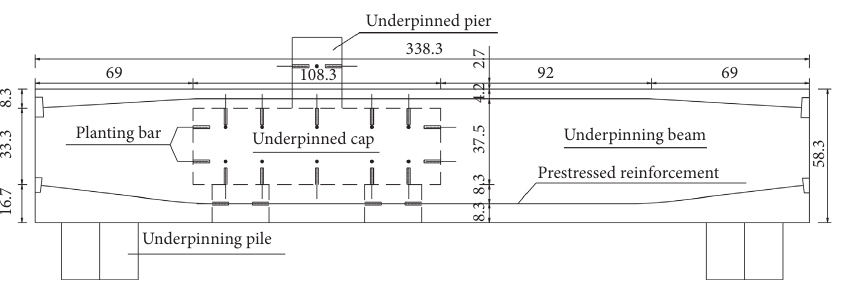
Figure 2: Side view of underpinning beam (cm).